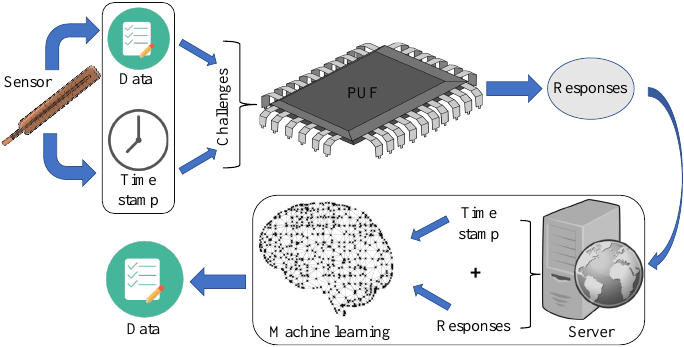
Figure 8. Proposed